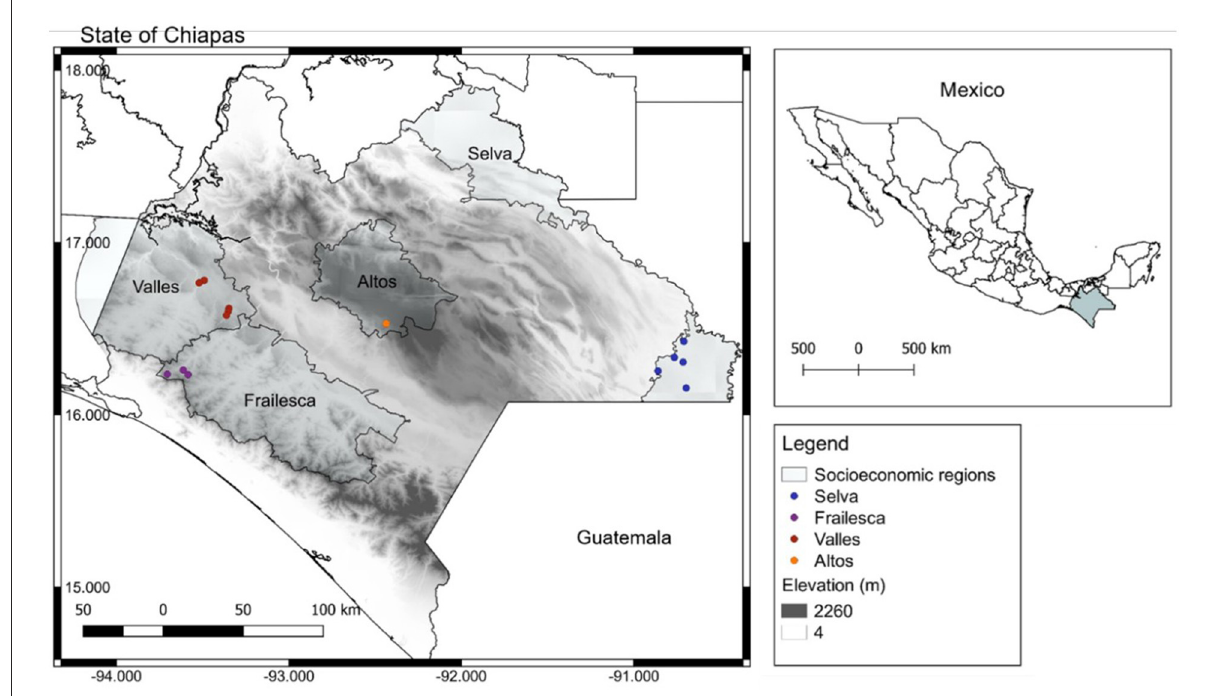
FIGURE1 Map of the location of the state of Chiapas and the four socioeconomic regions studied.